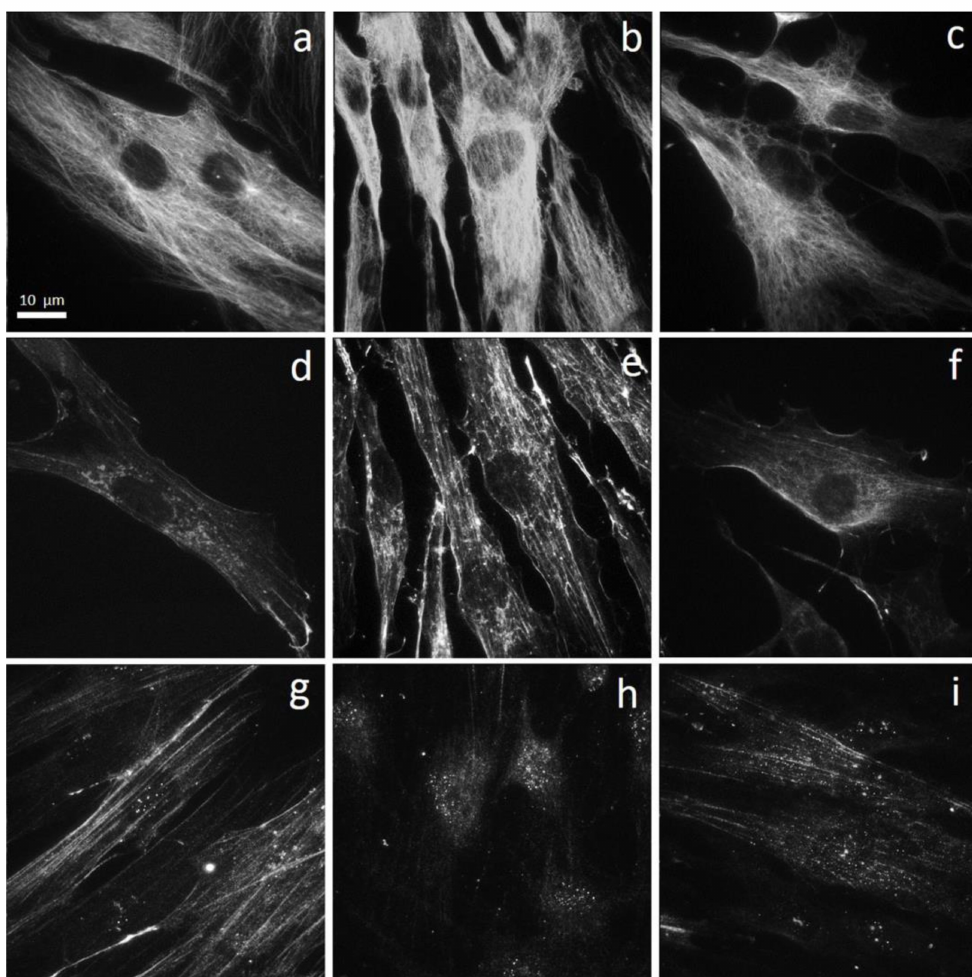
Figure 5. Effect of laser treatment on tubulin, α -actin, α -SMA expression, and distribution. Microscopy analysis of tubulin ( a - c ), α -actin ( d – f ), and α -SMA ( g – i ) expression evaluated by immunofluorescence (magnification 100 × ) on NHDF in basal conditions (CTRL; panels ( a , d , g )), stimulated with IL-1 β and TNF- α for 48 h (CYKs; panels ( b , e , h )), stimulated with IL-1 β and TNF- α for 48 h, and then exposed to laser treatments (3 treatments, repeated once a day, for 3 consecutive days) (CYKs + Laser; panels ( c , f , i )). Bar = 10 µ